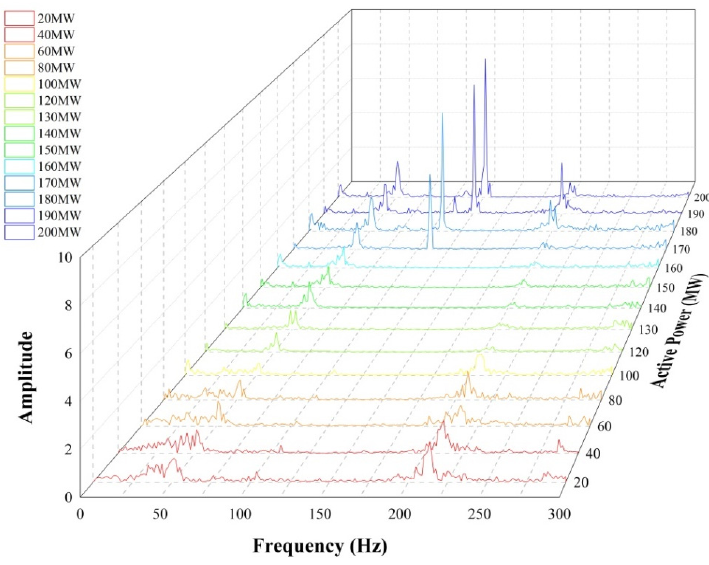
Figure 7. Spectrum of pressure pulsation at different load conditions.